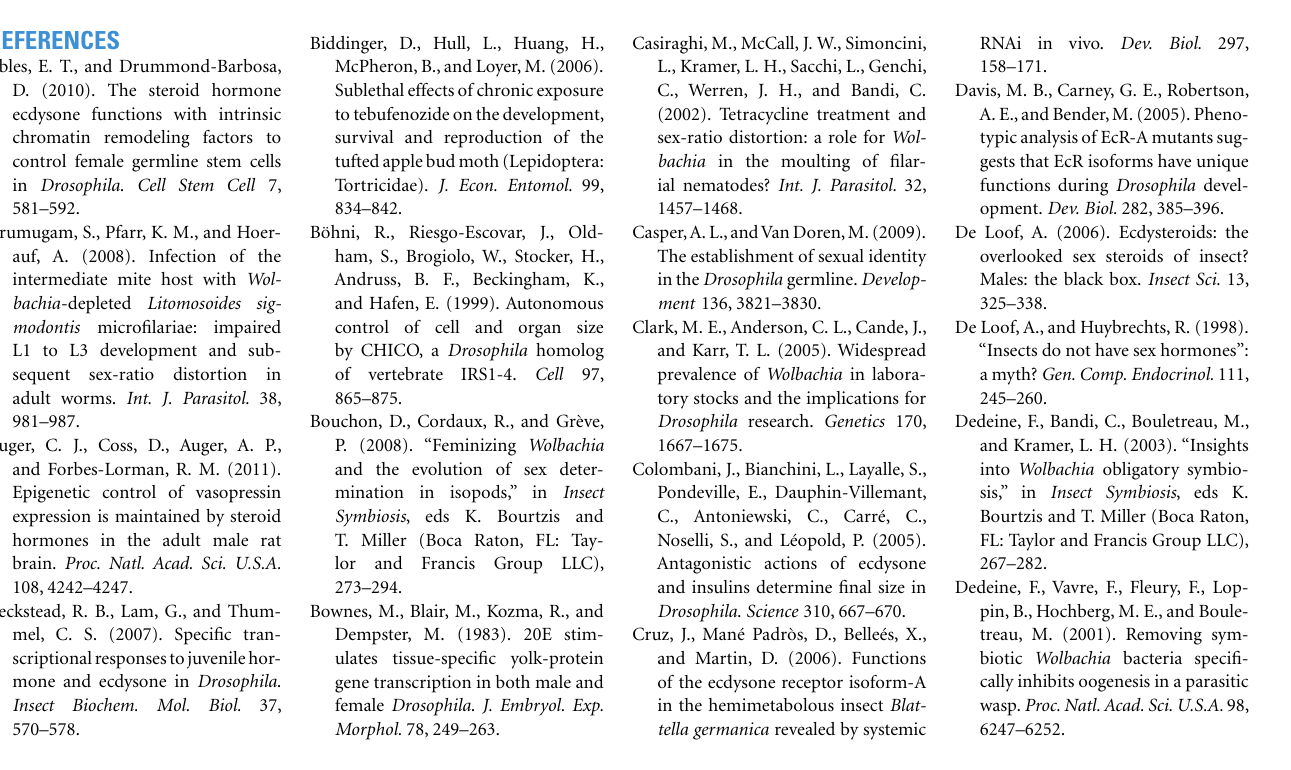
FIGURE 2 | Model illustrating the possible interplay between ecdysone signaling and epigenetic regulation, and Wolbachia action. 20E binds the nuclear receptor EcR which heterodimerizes with USP.Then, the EcR/USP complex binds DNA and complexes with nuclear receptor co-regulators, which catalyze DNA methyltransferases or directly function as histone